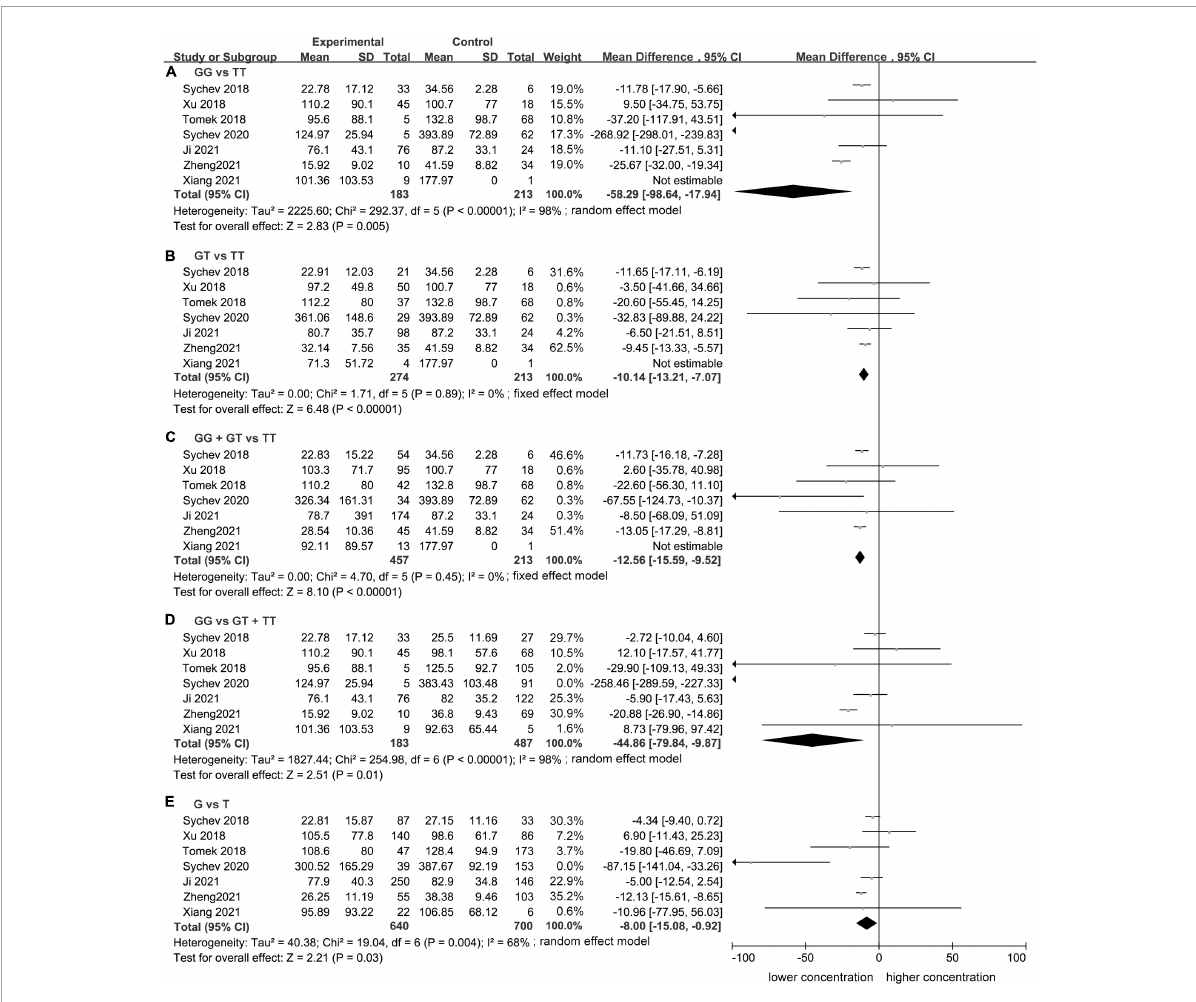
FIGURE1 Forest plots comparing dabigatran trough concentrations across rs2244613 genotype polymorphism of the carboxylesterase 1 ( CES1 ) gene: (A) homozygote model, (B) heterozygote model, (C) dominant model, (D) recessive model, and (E) allelic